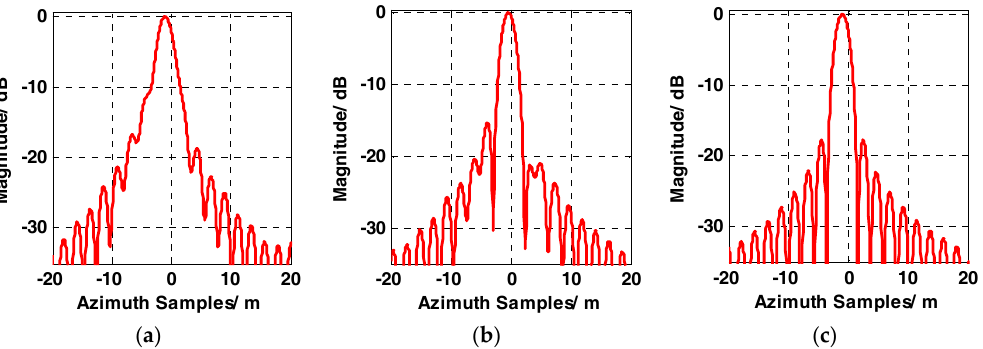
Figure 10. Target 5’s azimuth slices processed by ( a ) MD algorithm, ( b ) PGA algorithm, and ( c ) BLUE algorithm, for strip ‐ map SAR with mild accelerated motion error.